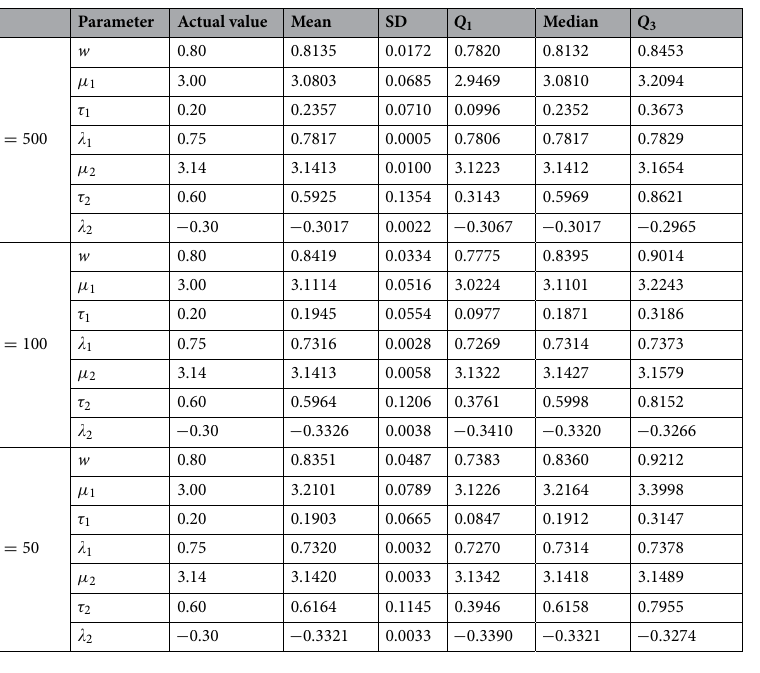
Table 3. Bayes estimates of parameters of a mixture of SSVM with prior parameters, µ 0 1 = 3 , τ 0 1 = 0.1 , α 1 = 4 , β 1 = 2 , ξ 1 = 0.9 , σ 1 = 0.15 , c 1 = 1 and µ 0